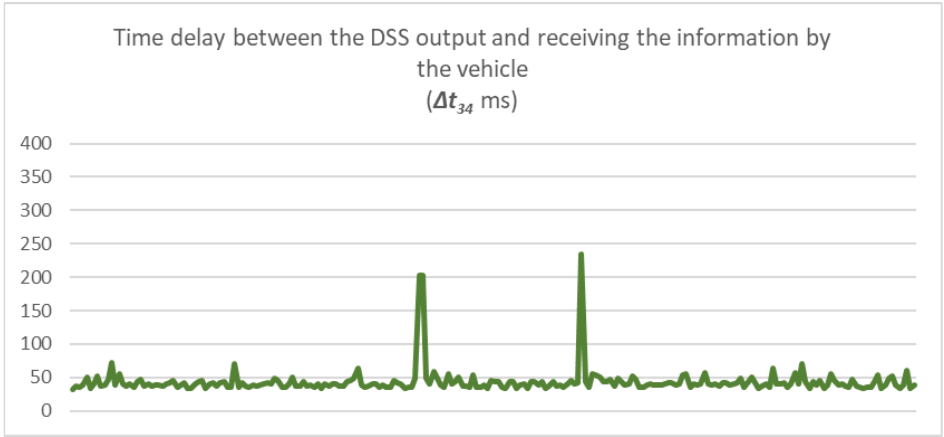
Figure 13. Time delay between the DSS output and receiving the information by the vehicle (Δt 34 vs. ms).